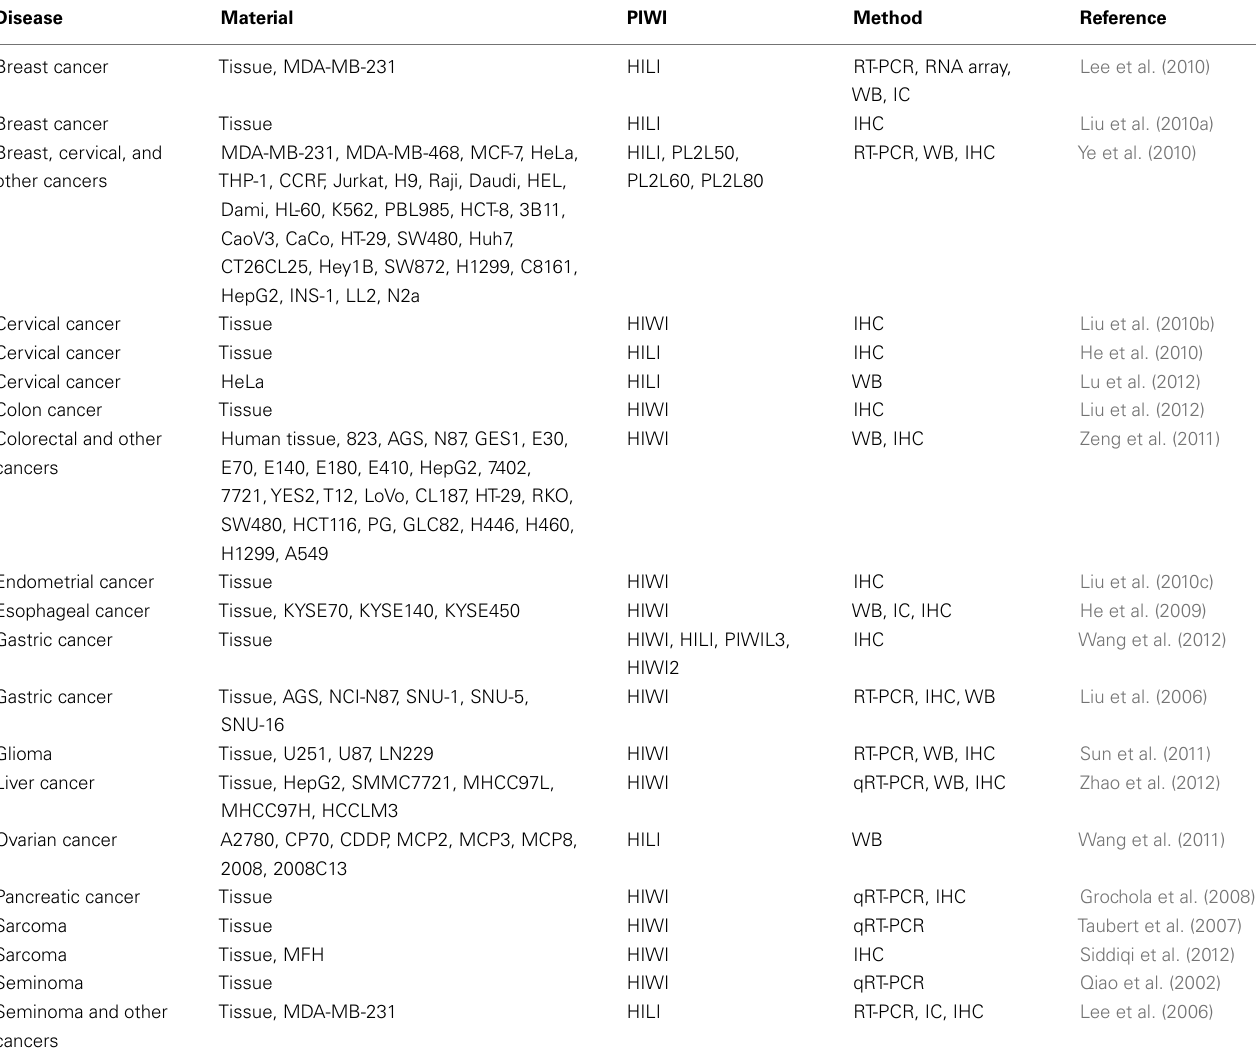
Table 2 | PIWI expression in human